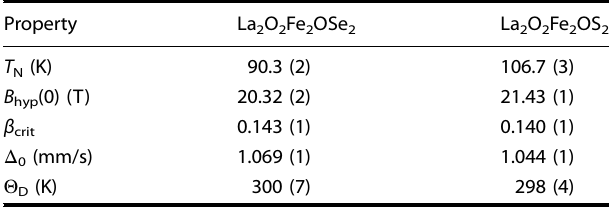
Table 1. Properties of the measured oxychalcogenide compounds obtained by Mössbauer